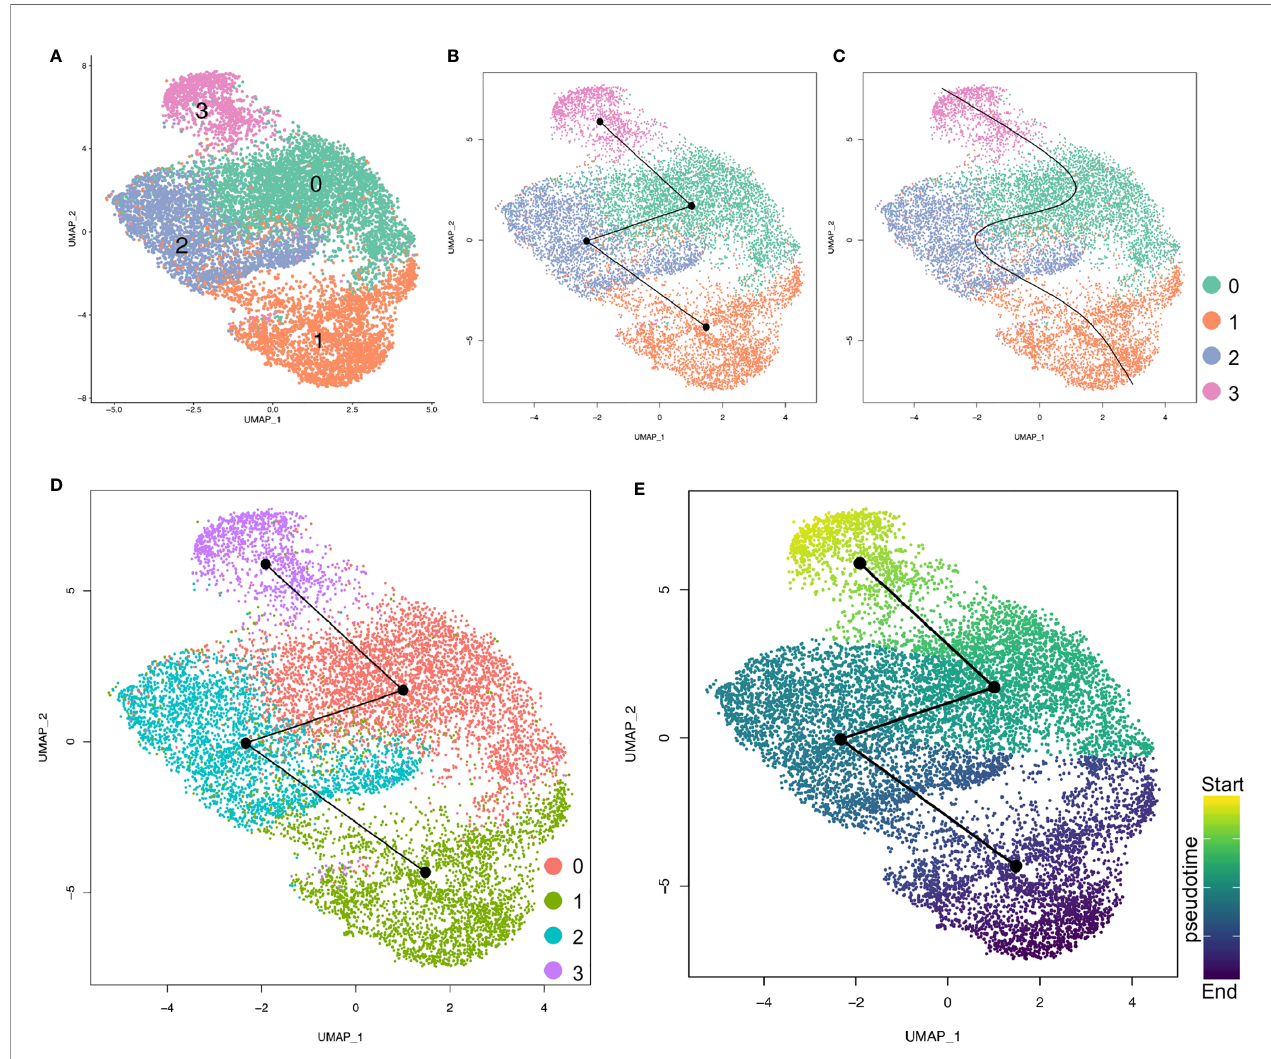
FIGURE 5 | Pseudotime analysis of cancer cell clusters with Slingshot. (A) Cancer cells were clustered under Slingshot packages and similar clusters were identi fi ed. (B, C) Inferred trajectory (B) and principal curves of each lineage (C) were visualized by UMAP. (D) Cluster information from Seurat were mapped to Slingshot and both analysis assays were matched. (E) Pseudotime values for each cancer cell cluster were visualized by UMAP. Color depth of each cell/cluster were correlated with pseudotime